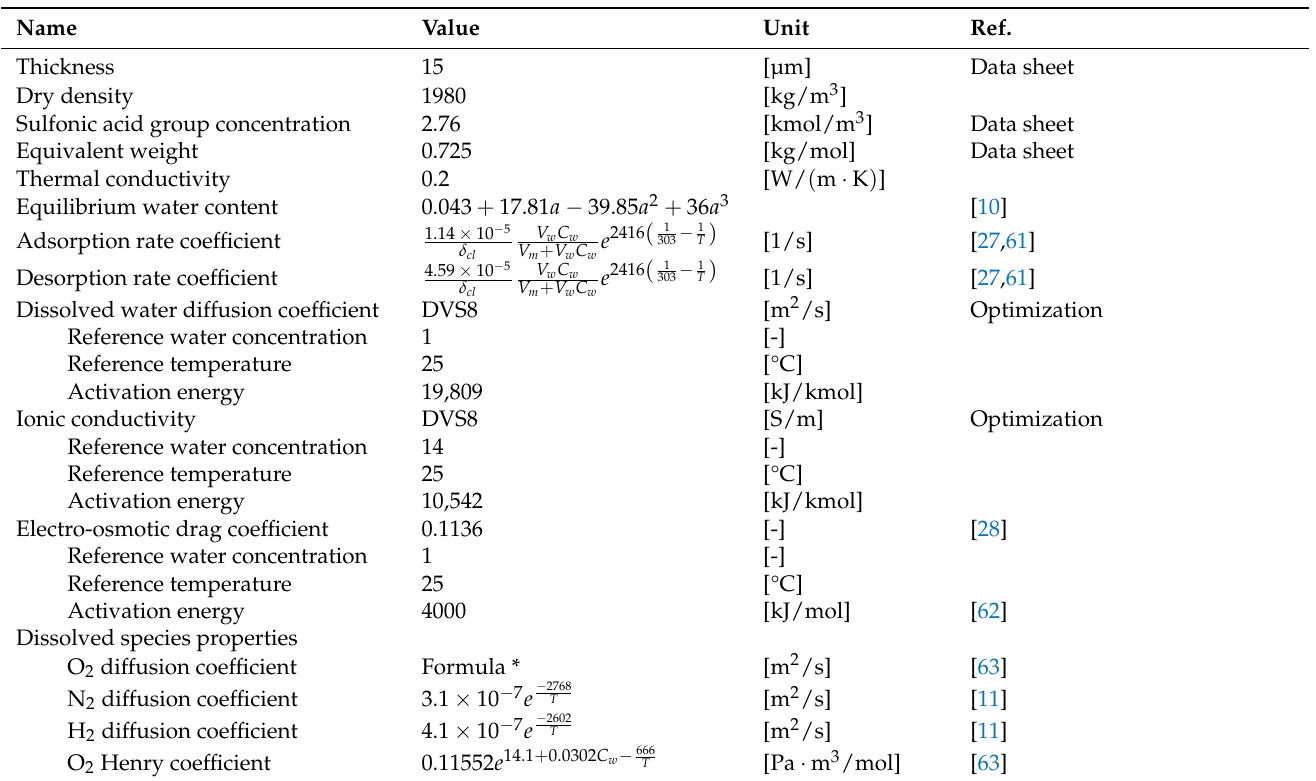
Table A1. Membrane